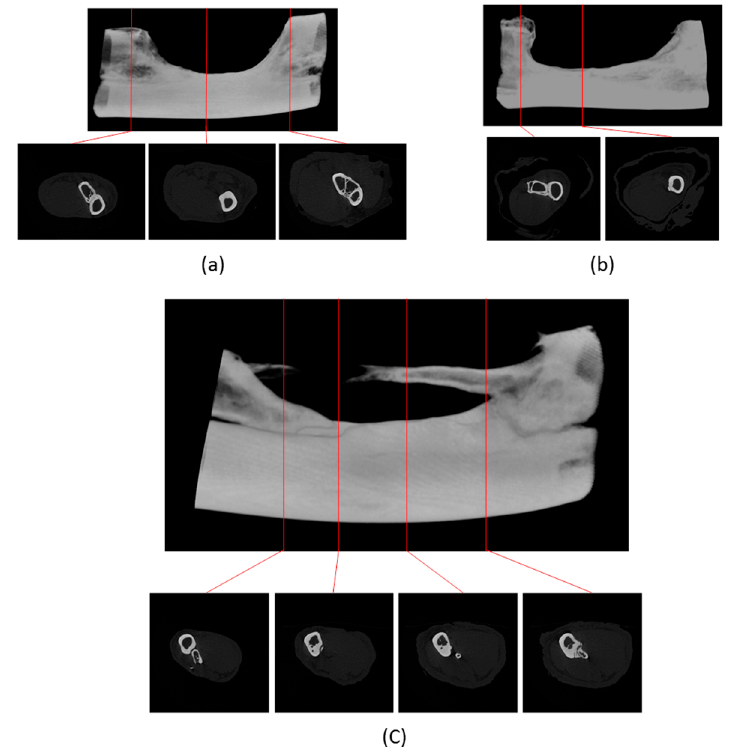
Figure 14. Critical-sized defect after 1 year of healing with differences under micro CT-scanning. ( a ) Control, no implantation; ( b ) polyurethane filler; ( c ) PL/PU 1:2 composite filler.